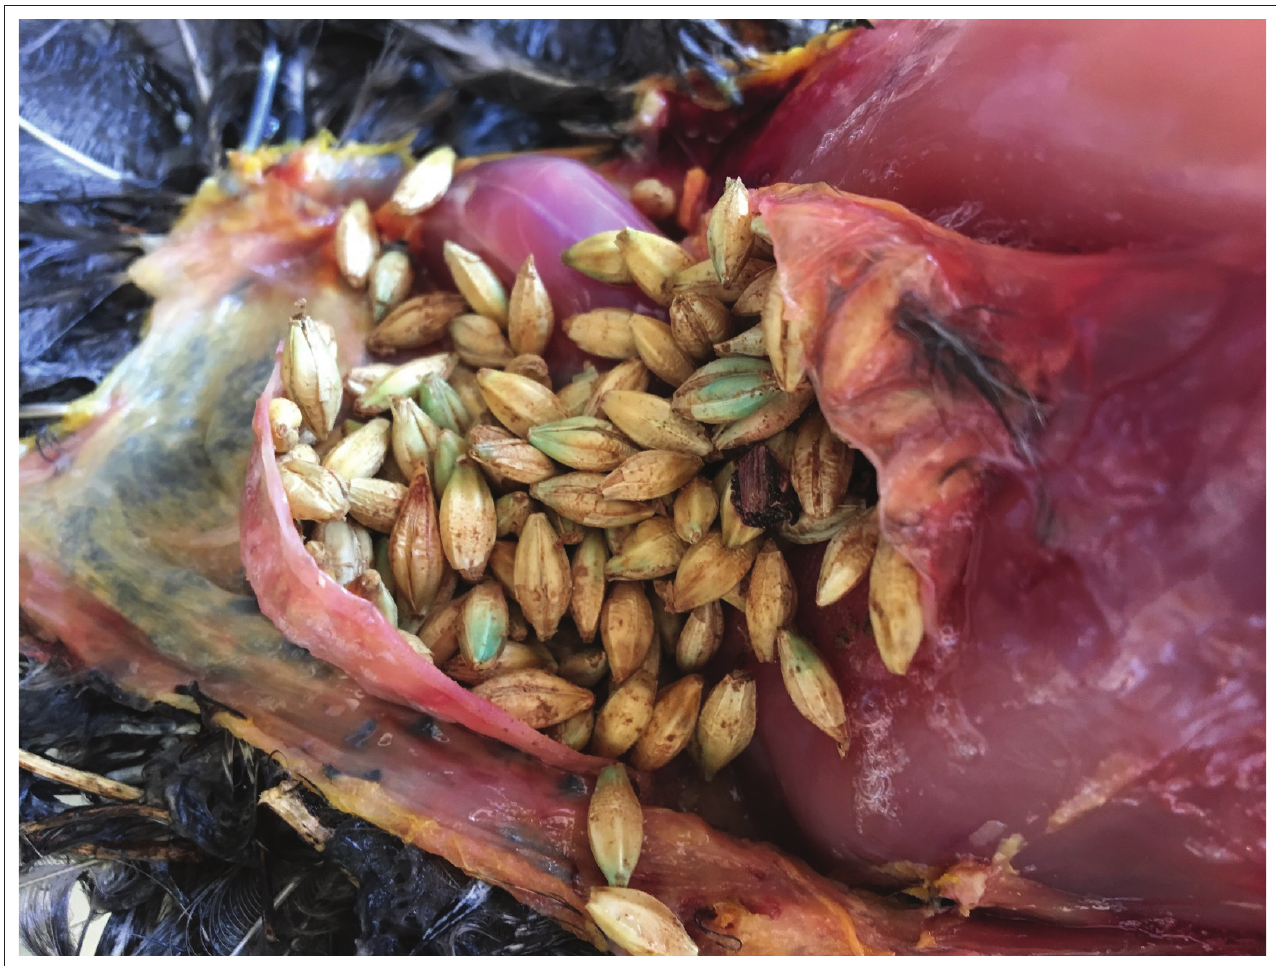
FIGURE 1: Crop contents with bluish discoloured barley seeds